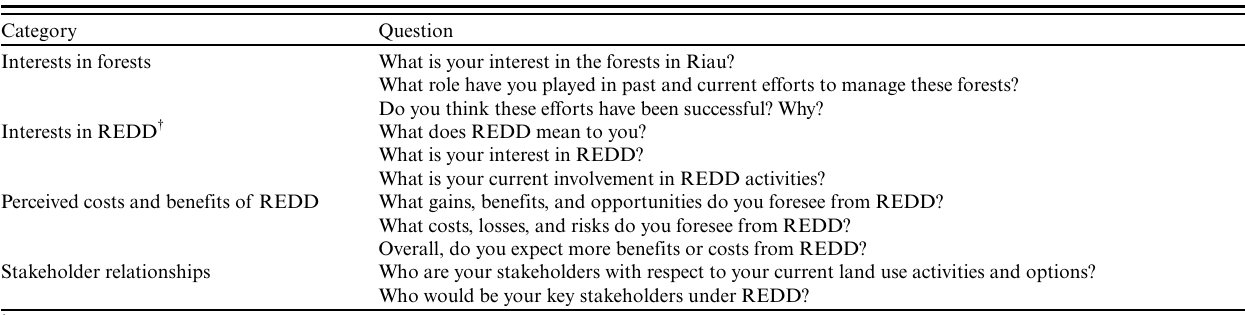
Table 2. Questions asked during stakeholder group